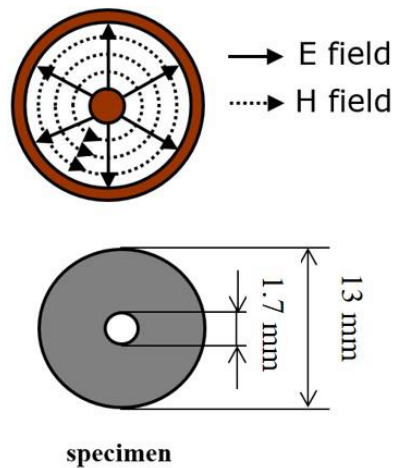
Figure 1. Schematic of free-space set-up for electromagnetic interference (EMI) shielding measure- ment. CFRP: carbon fiber-reinforced polymer.